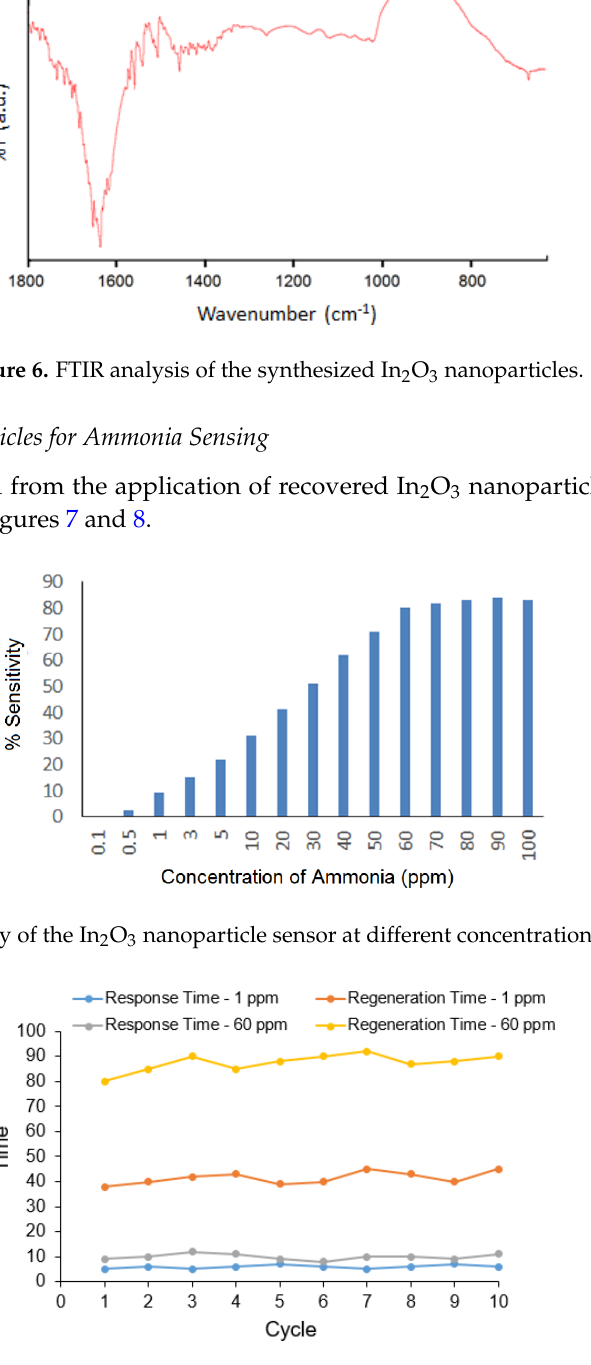
Figure 8. Response and recovery of the In 2 O 3 nanoparticle sensor at low (A: 1 ppm) and high concentrations of ammonia (B: 60 ppm) during successive cycles.